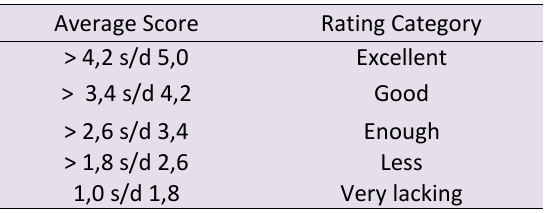
Table 1. Product Rating